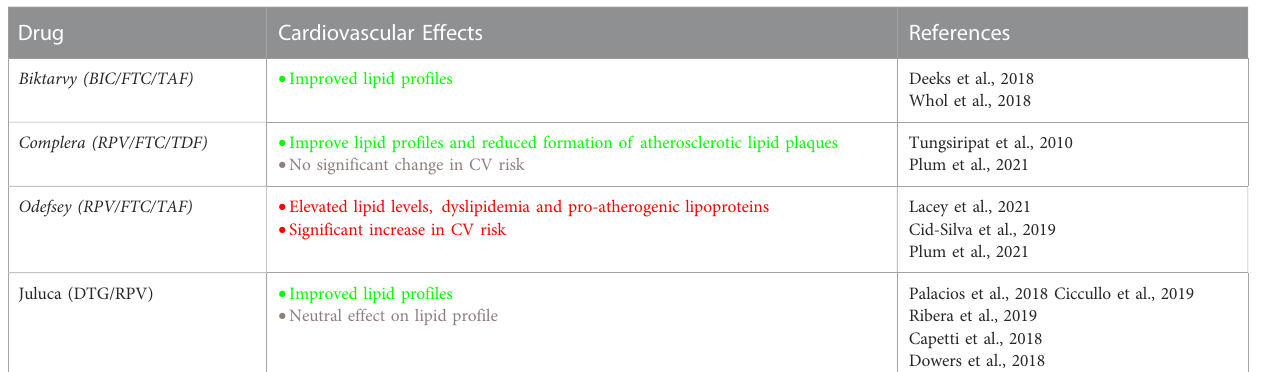
TABLE 2 cART Drug Combinations and Cardiovascular Health